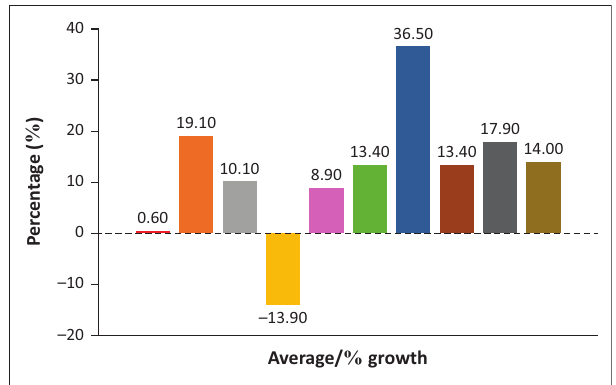
FIGURE 2: Companies’ average percentage growth from 2010 to